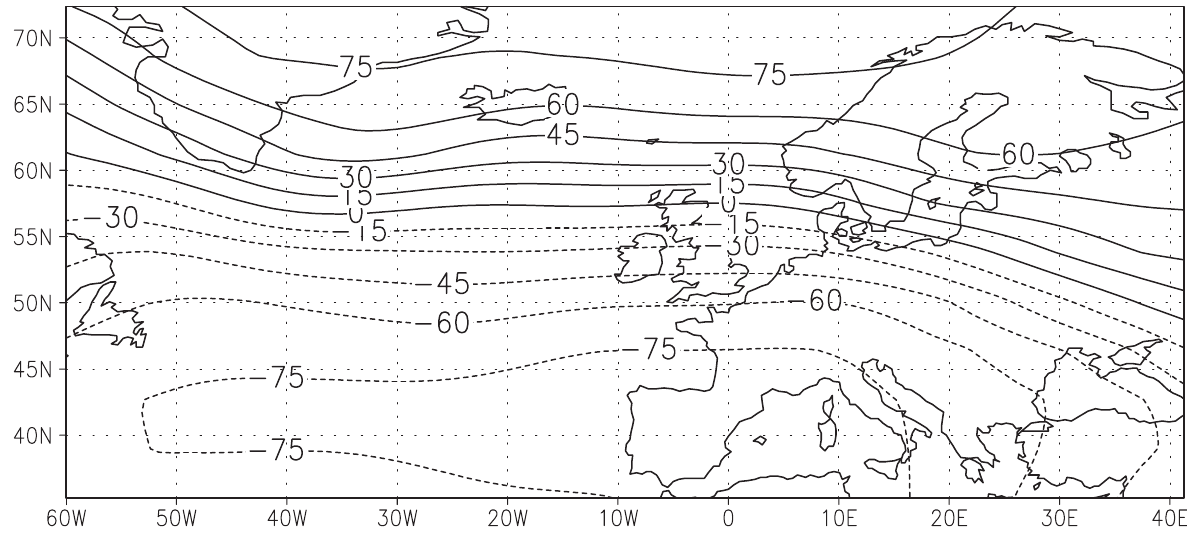
Fig. 6. First EOF pattern (explaining 38% of the total variance) of model simulated JFM seasonal mean Atlantic/ European